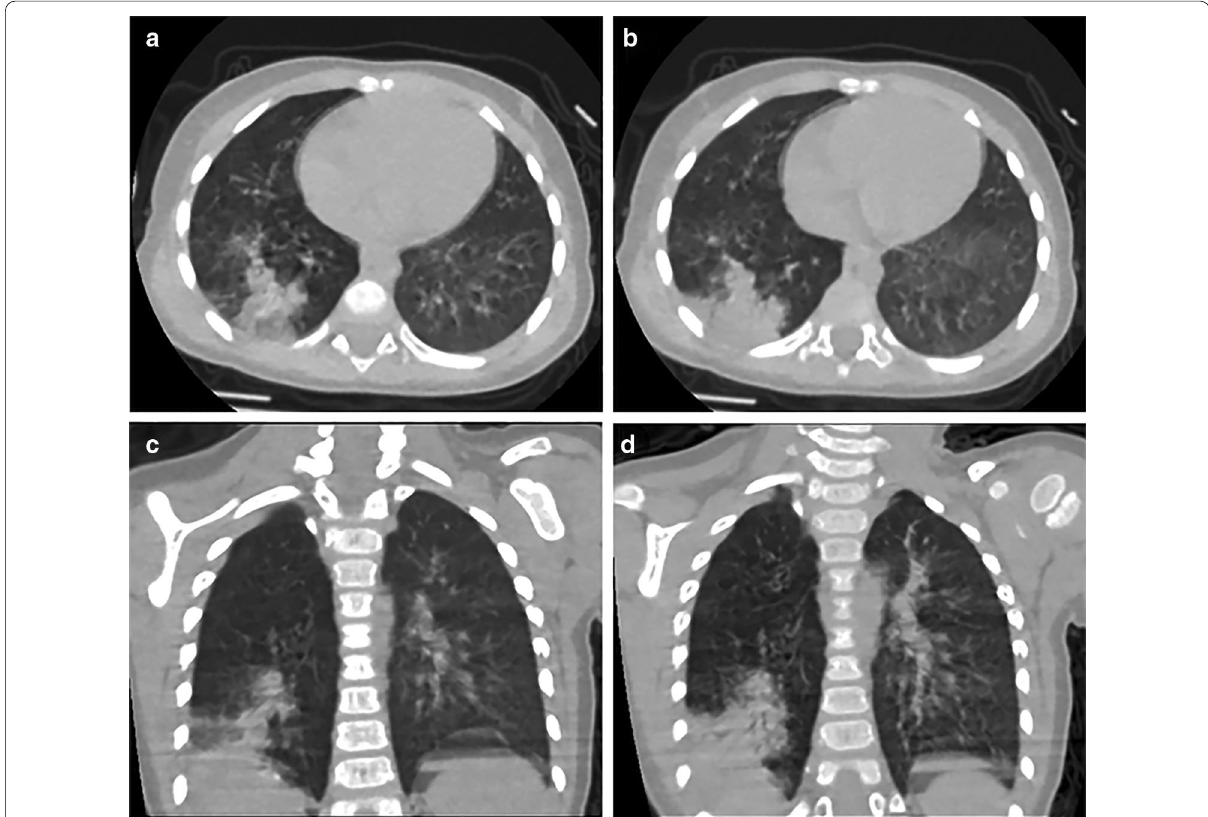
Fig. 4 A two‑year‑old male child with positive RT‑PCR findings for COVID‑19. a – d Noncontrast axial CT images of the chest show right lower‑lobe peripheral consolidation and surrounding ground‑glass opacity. This is in keeping with his CO‑RADS 4 and indeterminate RSNA